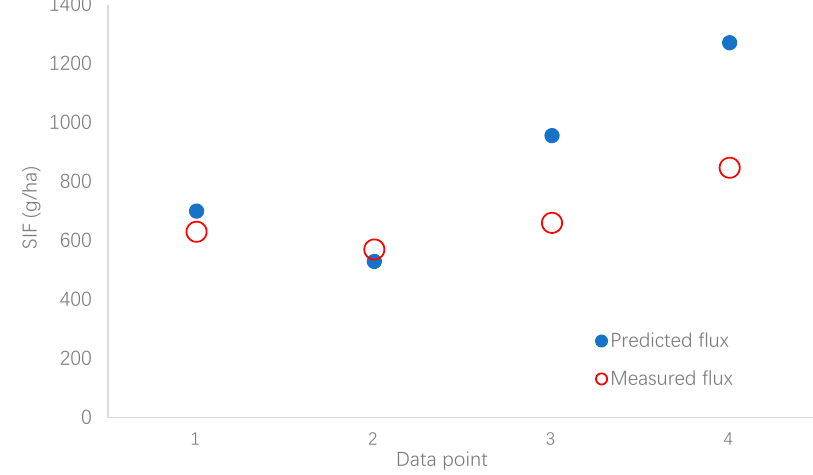
Figure 10. Scatter plot of the actual nitrous oxide emissions versus the ANN predicted emission.